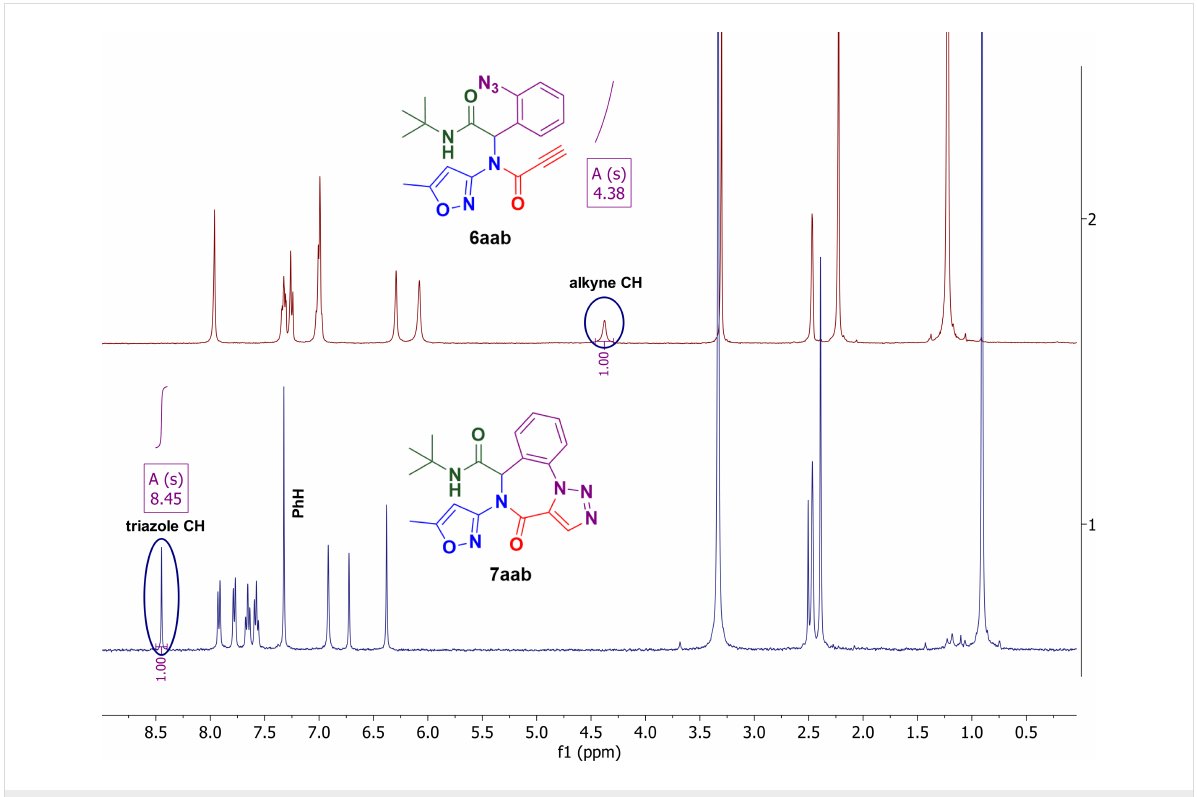
Figure 4: 1 H NMR spectra of the reactant and the product of IAAC.